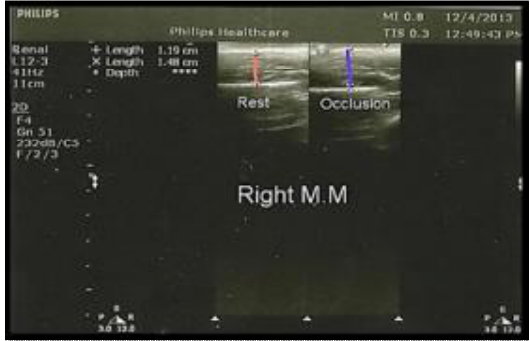
Figure 4: Right Masseter Muscle Thickness Scanning, the Red Arrow Representing the Masseter Muscle Thickness (mm) under Rest Condition, the Blue Arrow Representing the Masseter Muscle Thickness (mm) under Occlusion Condition.